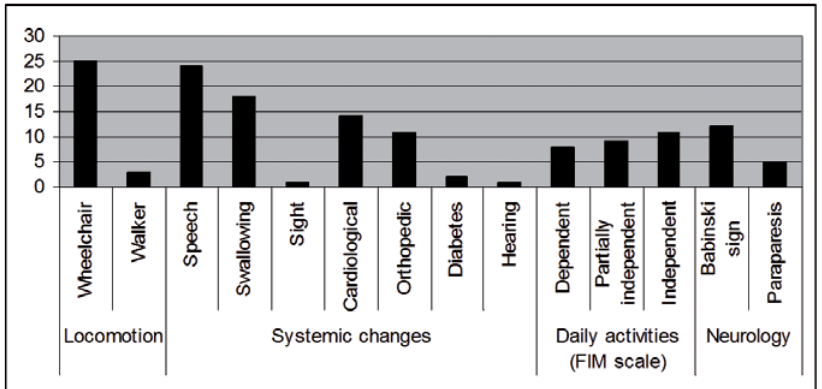
Figure 1 - Frequency of non-urological features in 28 patients with